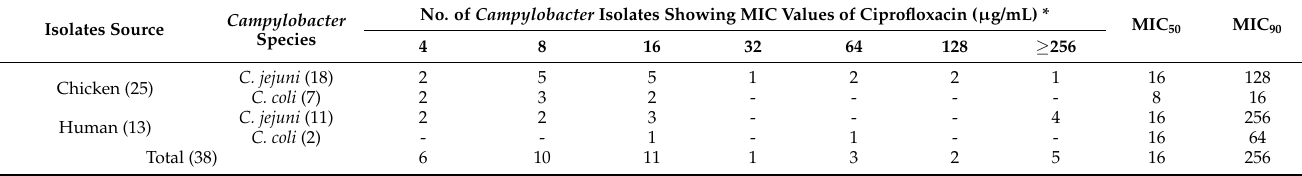
Table 4. Minimal inhibitory concentrations of ciprofloxacin against Campylobacter isolates from different sources. Isolates